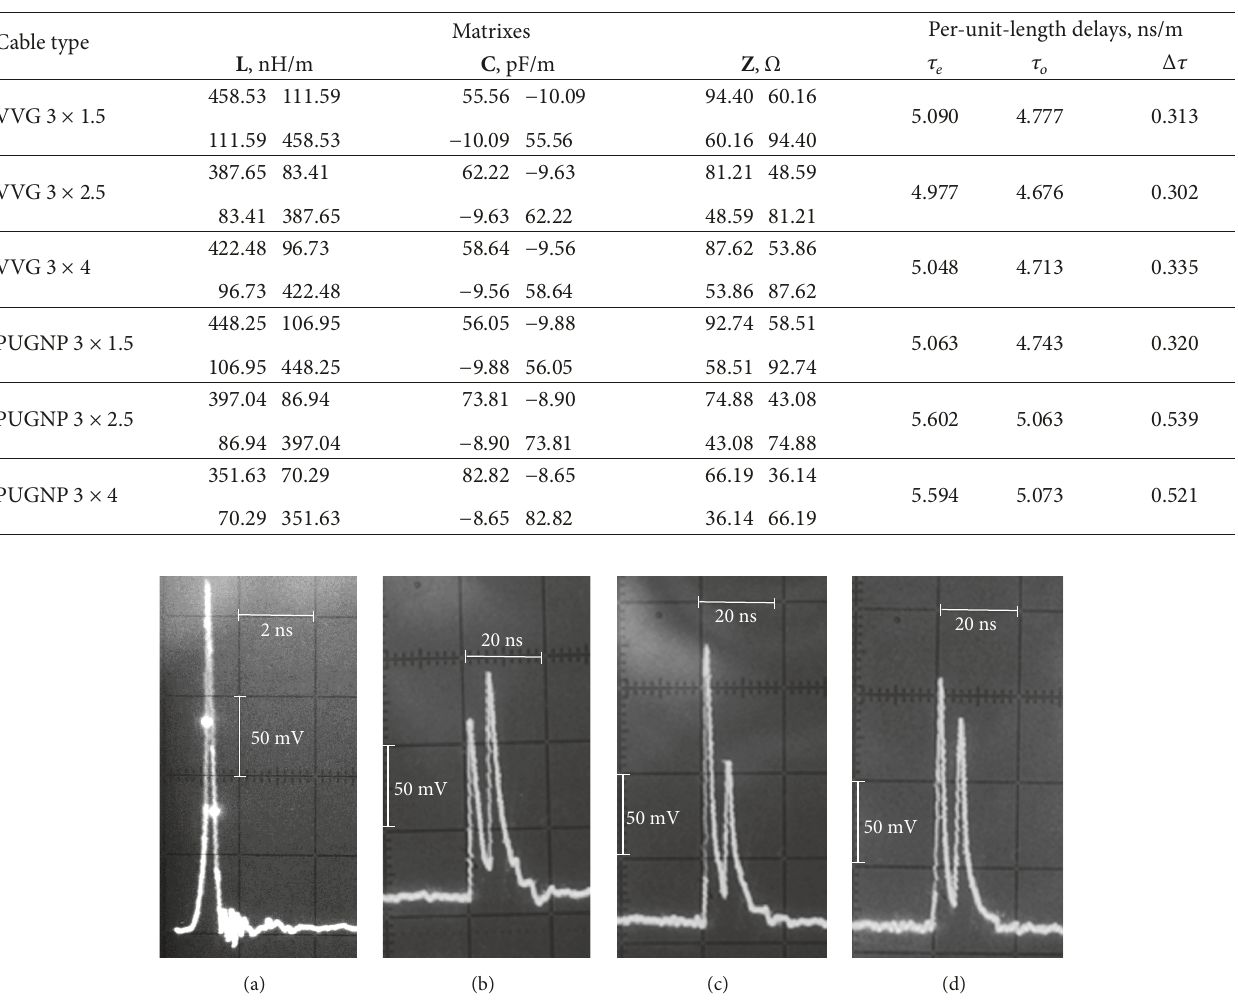
Table 6: L , C , and Z matrixes, mode per-unit-length delays, and their difference for the cables under consideration.